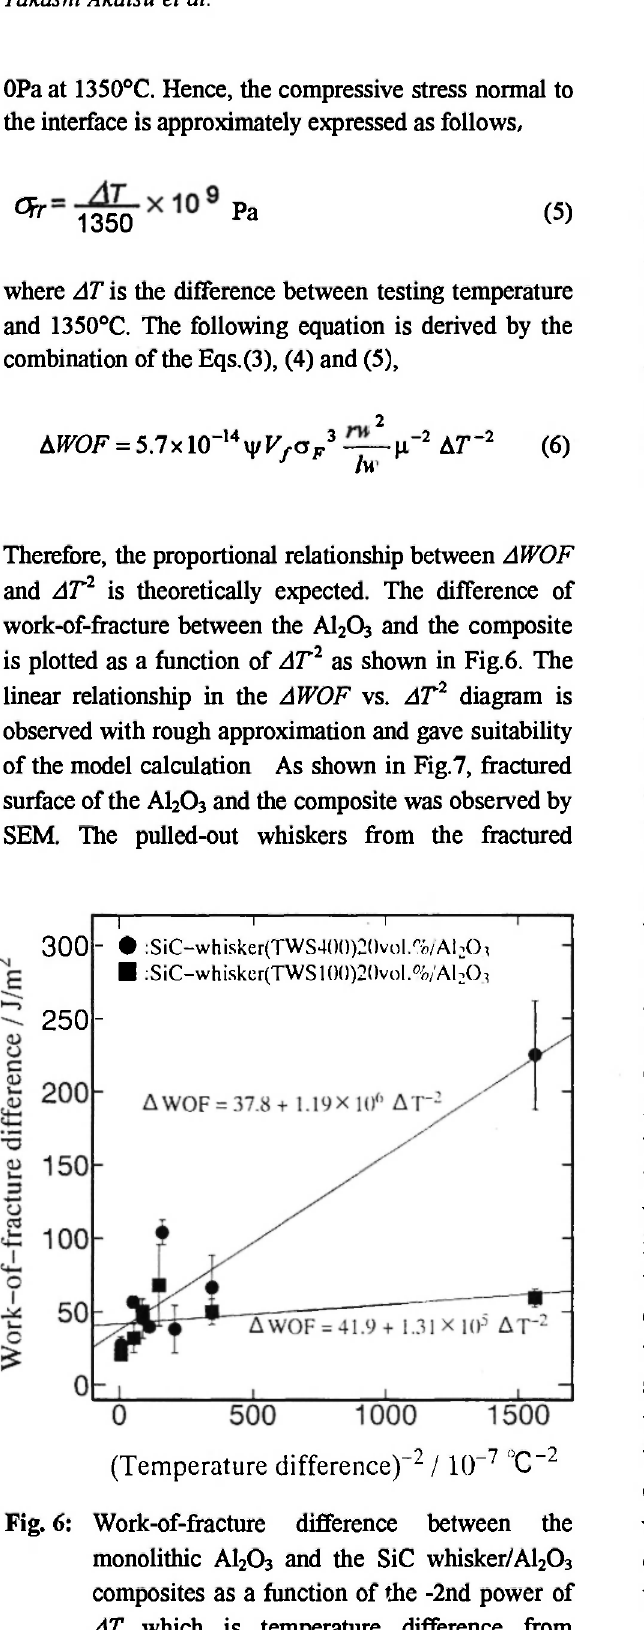
Fig. 6: Work-of-fracture difference between the monolithic AI2O3 and the SiC whisker/Al composites as a function of the -2nd power of AT which is temperature difference from